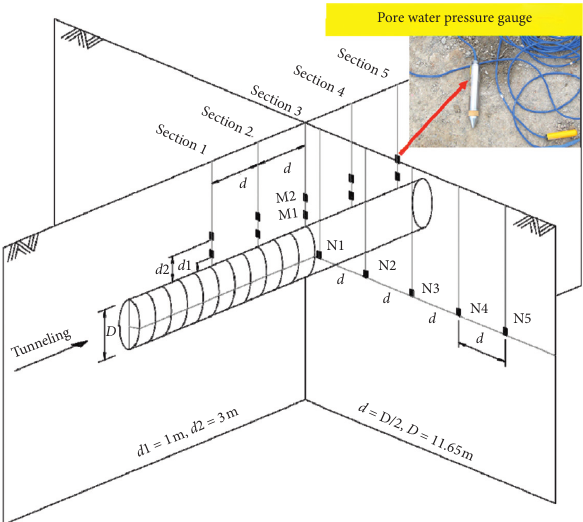
Figure 3: Layout of the pore water pressure testing